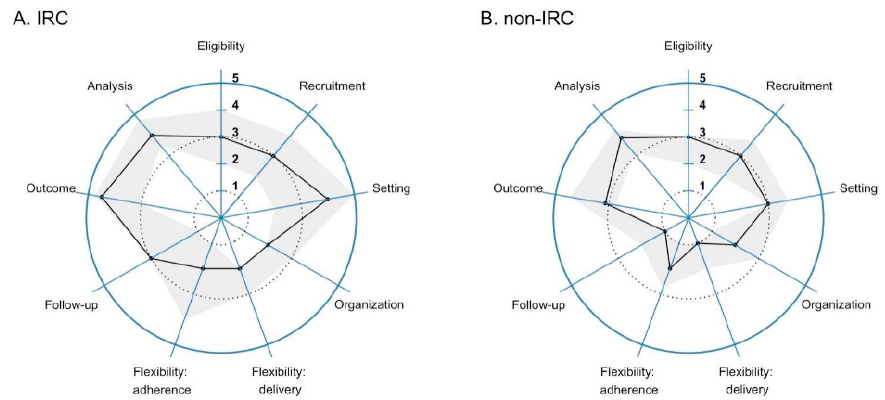
Figure 3. The Pragmatic Explanatory Continuum Indicator Summary 2 (PRECIS-2) wheel ranking the degree of pragmatism for the nine PRECIS-2 domains stratified by whether the investigator worked in an Intervention Research Center (IRC) or in central coordination. In this figure, we show the median and interquartile range for the responses of the 35 Household Air Pollution Intervention Network (HAPIN) investigators. Panel A plots the responses for IRC investigators (n = 21) and Panel B for investigators working in central coordination (n = 14). We report median (black line) and interquartile range (gray shaded area) ranks of the responses. It uses a five-point Likert rank scale from very explanatory (1) to very pragmatic (5) to rank each of these domains.